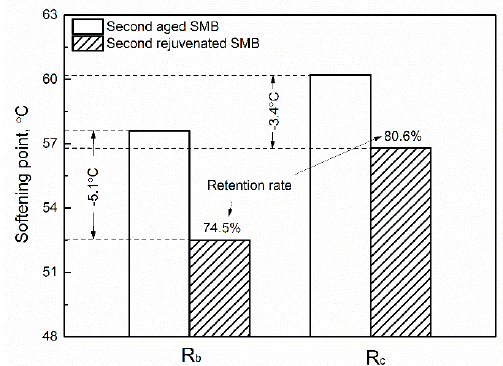
Figure 2. Effect of rejuvenating systems on the softening point of second-aged SMB.